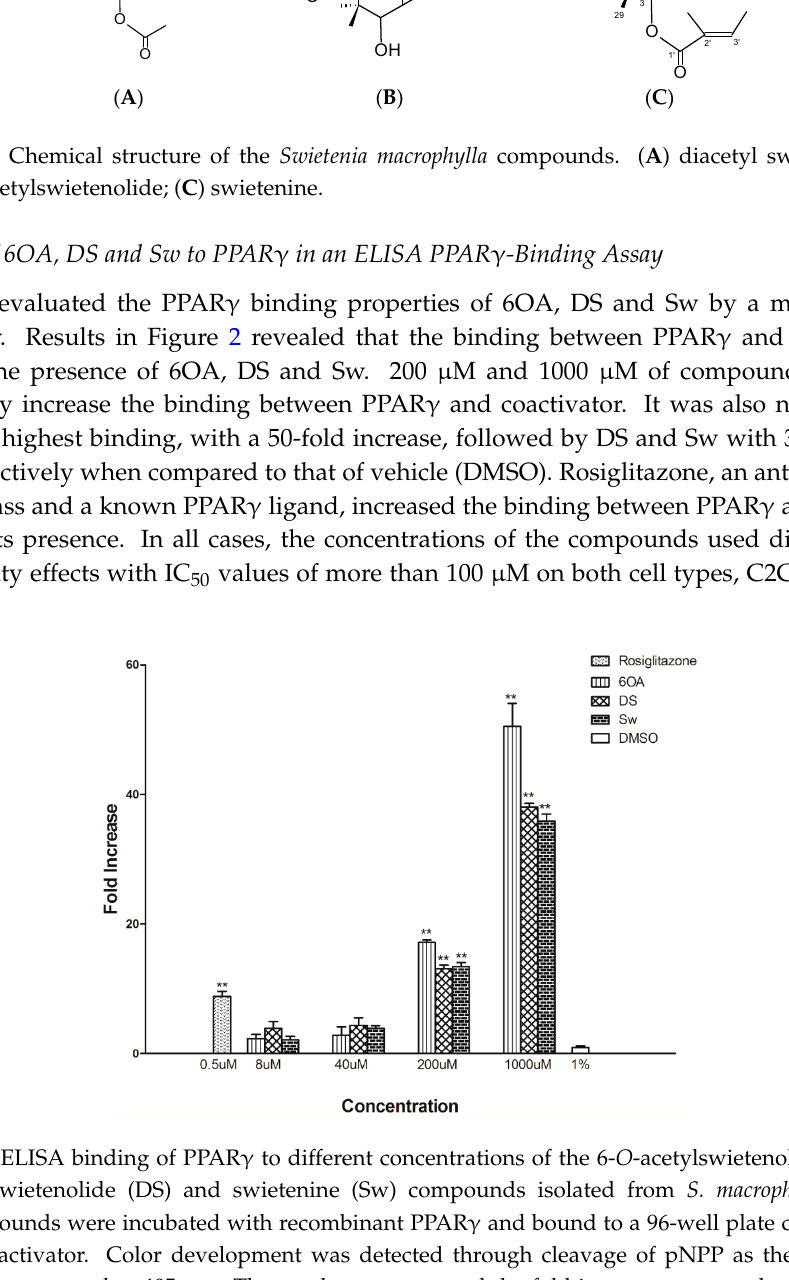
Figure 2. ELISA binding of PPAR γ to different concentrations of the 6- O -acetylswietenolide (6OA), diacetyl swietenolide (DS) and swietenine (Sw) compounds isolated from S. macrophylla seeds. The compounds were incubated with recombinant PPAR γ and bound to a 96-well plate coated with a p300 coactivator. Color development was detected through cleavage of pNPP as the substrate, and it was measured at 405 nm. The results are presented the fold increase compared with DMSO. Rosiglitazone, a known PPAR γ ligand, was used as a positive control. The symbol ** denotes a significant difference at p < 0.01 compared with DMSO (Tukey’s test, n =